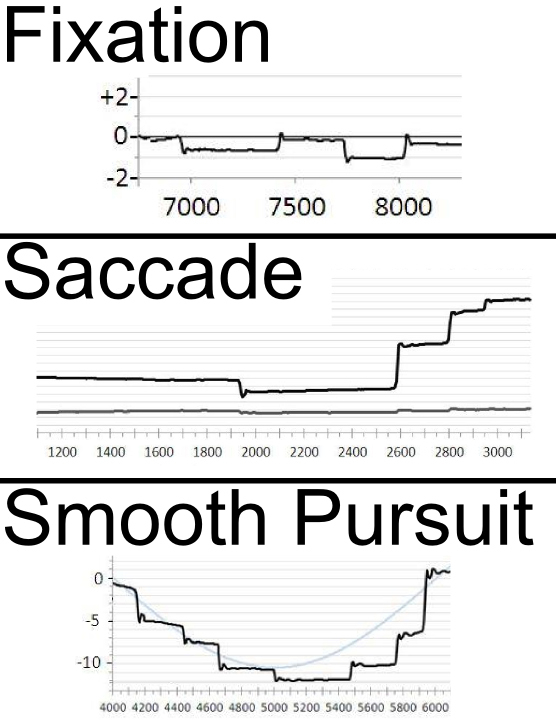
Oculomotor function in the ‘visual dementia’ posterior cortical atrophy (PCA) has received little attention. Shakespeare et al. report impairments in fixation, saccade and smooth pursuit in patients with PCA and typical Alzheimer’s disease, and suggest that oculomotor impairment should be considered a core feature of the PCA syndrome.